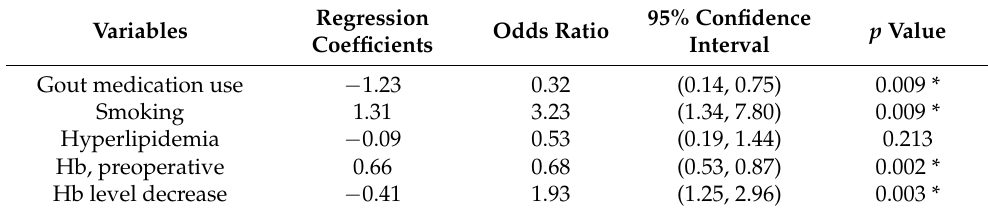
Table 3. Results of multivariate logistic regression